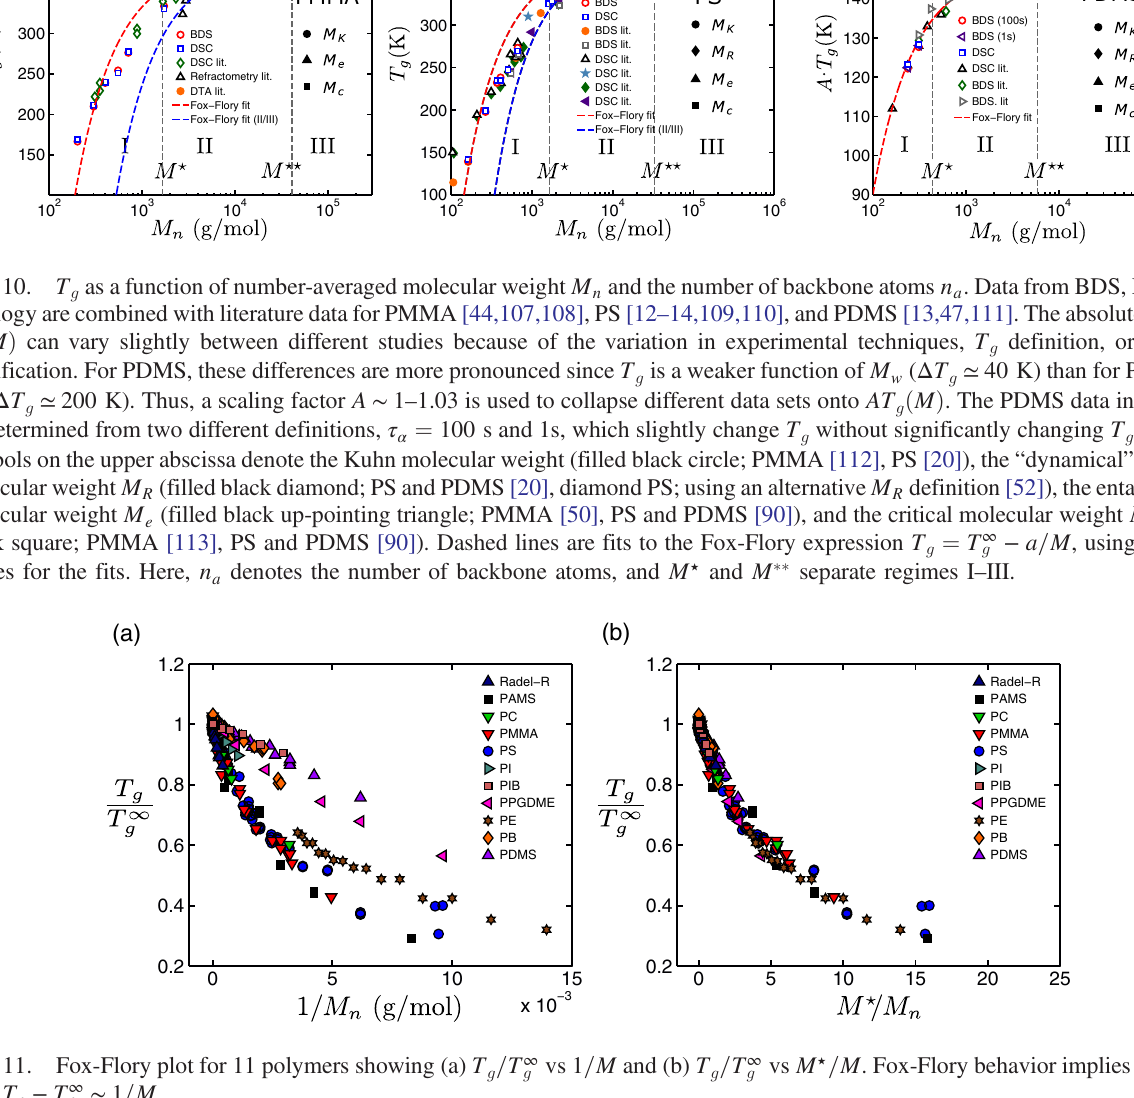
FIG. 11. Fox-Flory plot for 11 polymers showing (a) T − T ∞ ∼ 1 =M line, T g g